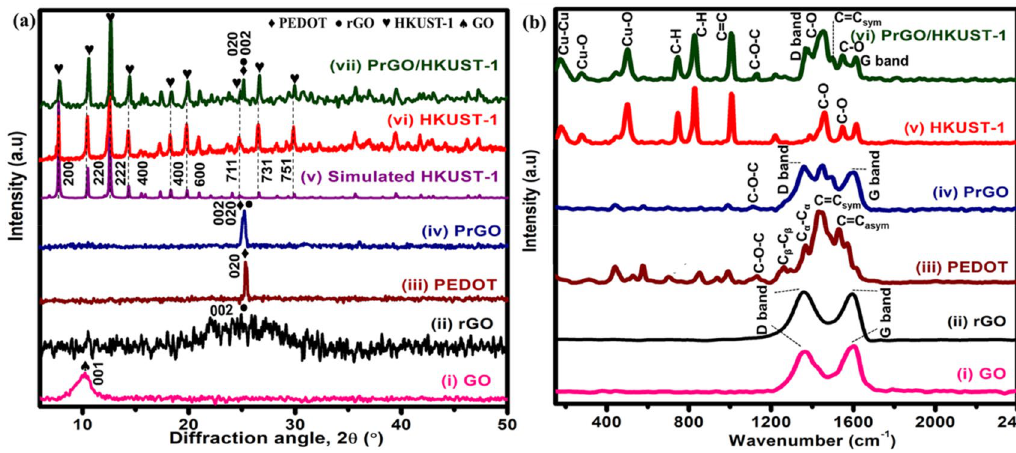
Figure 2. ( a ) XRD patterns and ( b ) Raman spectra of GO, rGO, PEDOT, PrGO, HKUST-1 and PrGO/HKUST-